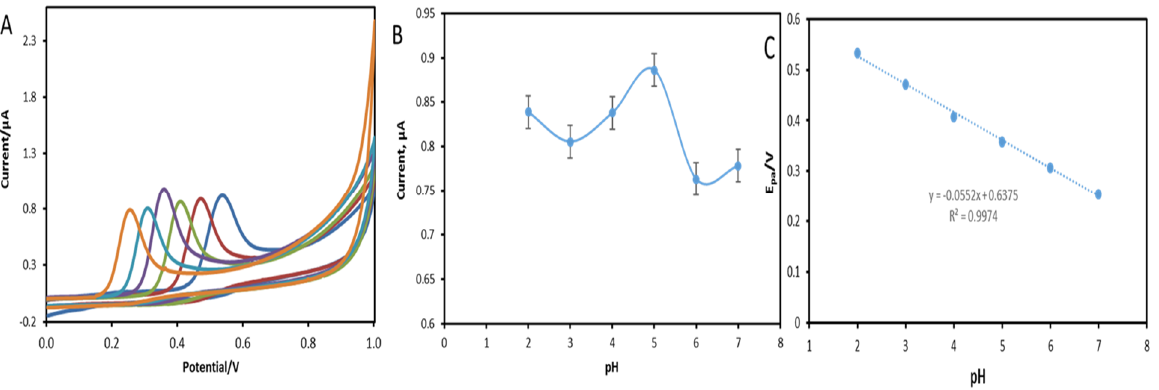
Figure 6. ( A ) CVs of the effects of pH on the oxidation. ( B ) Plot of estradiol peak current vs. pH. ( C ) A plot of peak potential versus pH.